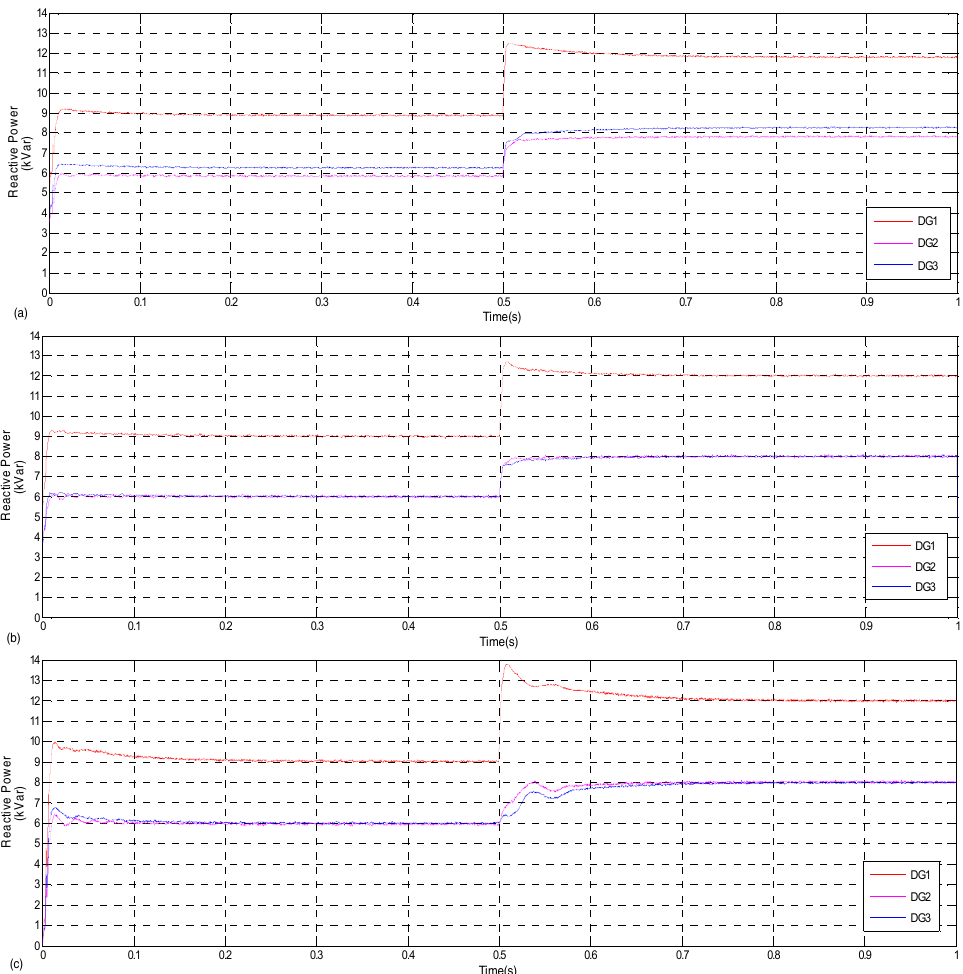
Figure 9. Simulation results in Case C: ( a ) reactive power with ε is 0.1; ( b ) reactive power with ε is 0.01; and ( c ) reactive power with ε is 0.001.